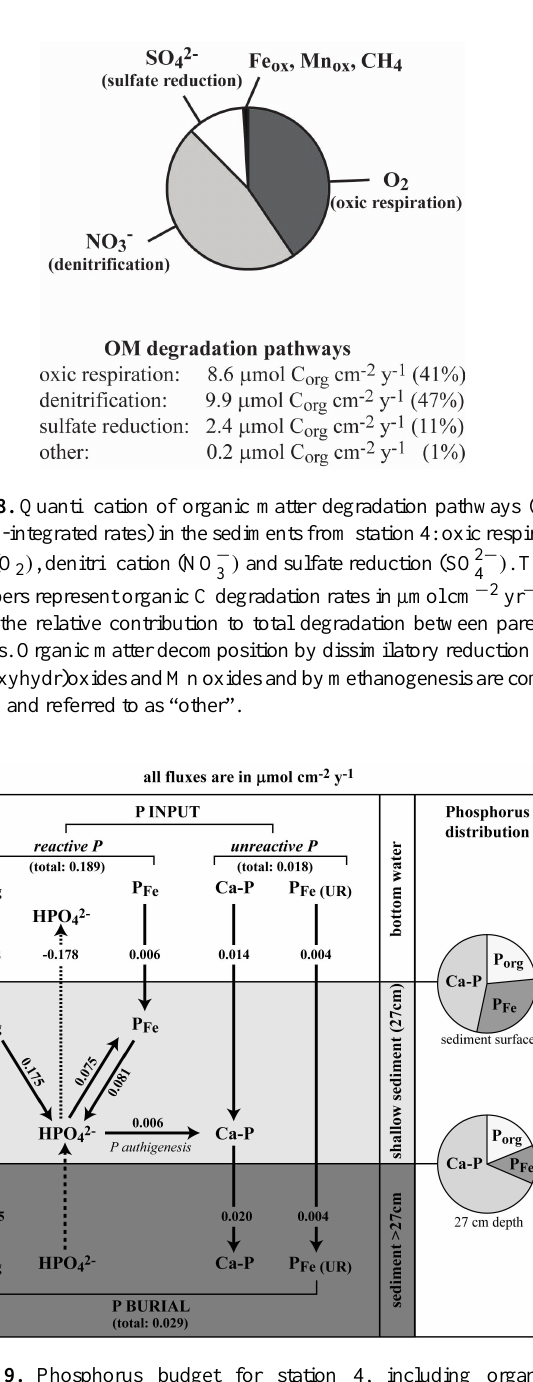
Fig. 9. Phosphorus budget for station 4, including organic P (P org ) , reactive Fe-bound P (P Fe ) and P bound to unreac- tive Fe (oxyhydr)oxides (P Fe ( UR ) ) and Ca-P. All fluxes are in µmolcm − 2 yr − 1 . Phosphorus input is the total depositional flux of P at the sediment-water interface. The HPO 2 − efflux is the net sum 4 of diffusion, bioirrigation and boundary exchange. The right panel shows the modelled diagenetic changes in sedimentary P speciation with depth.